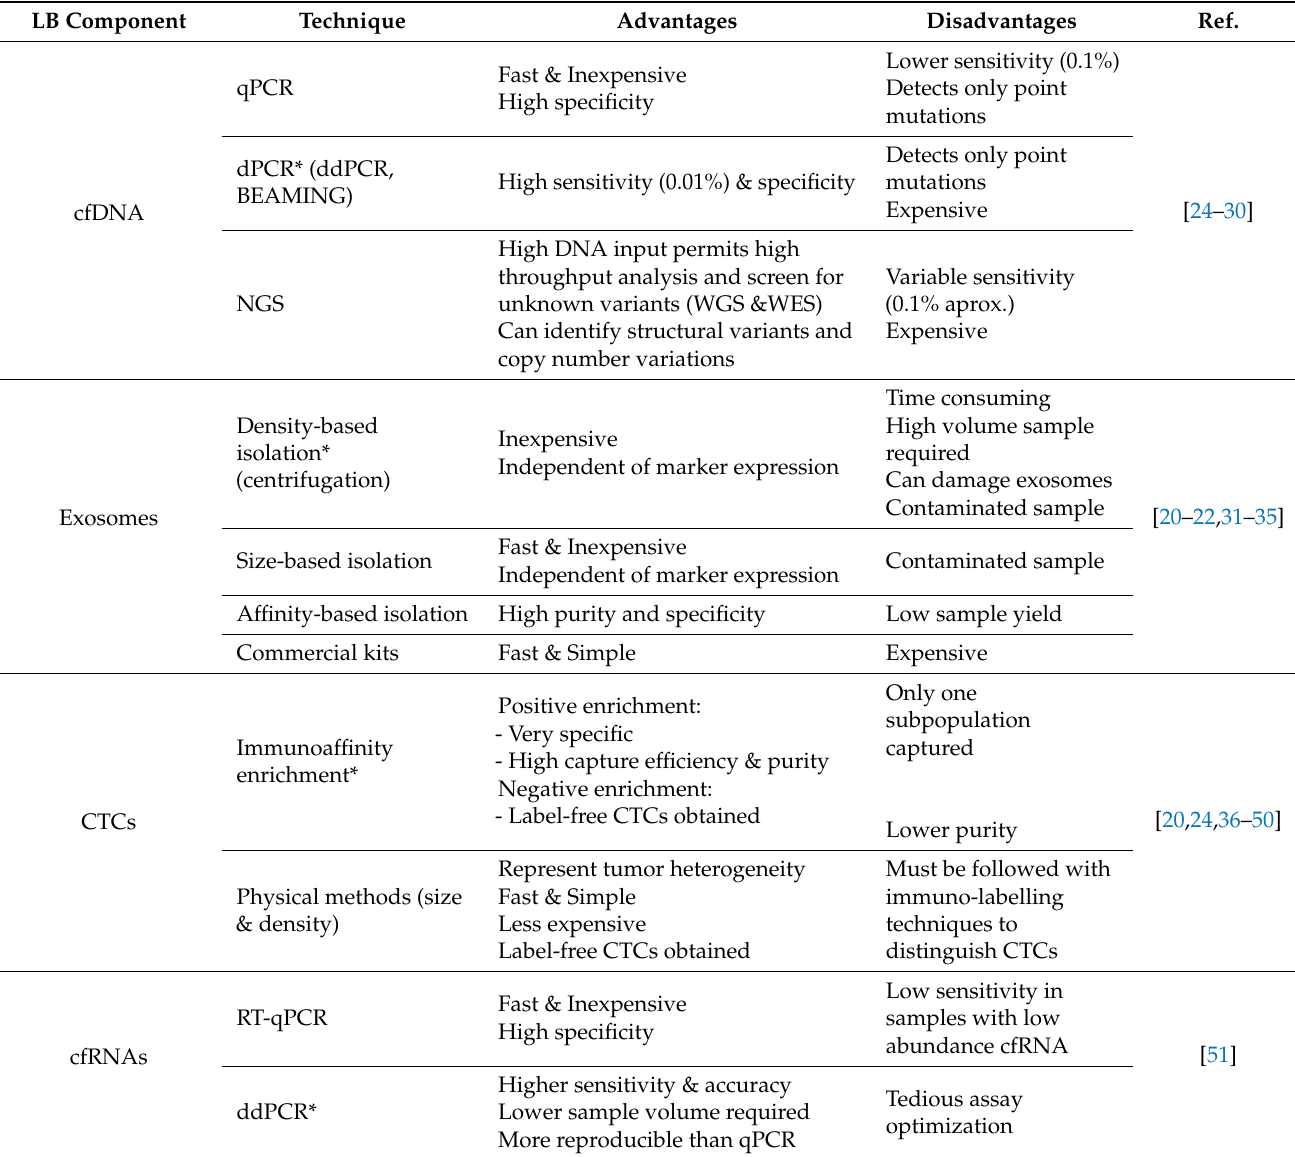
Table 1. Methods for isolation and analysis of liquid biopsy components in pancreatic cancer. Overview of the advantages and disadvantages of the described